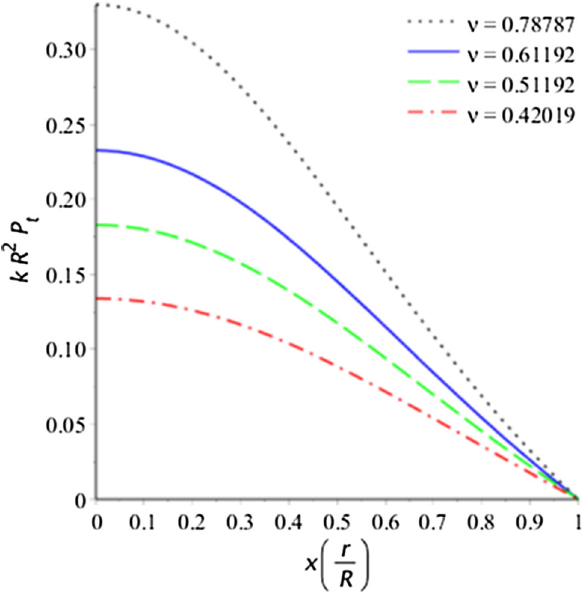
Fig. 5 Graphical representation of tangential pressure for w = − 0 . 9